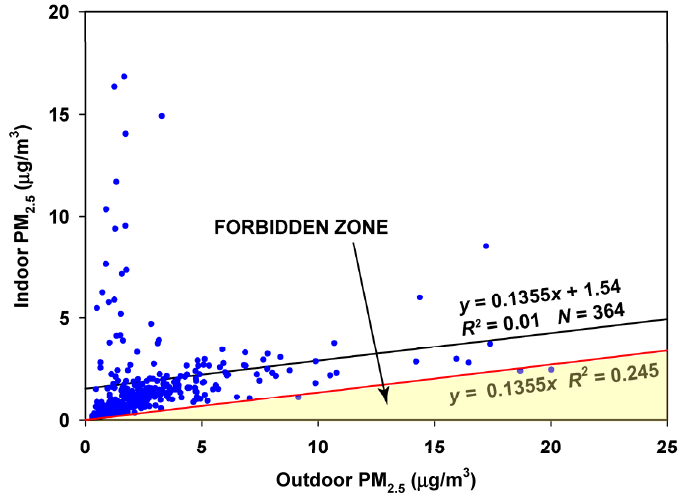
Figure 5. RCS regression of indoor on outdoor air for the December through May data in Oakmont.